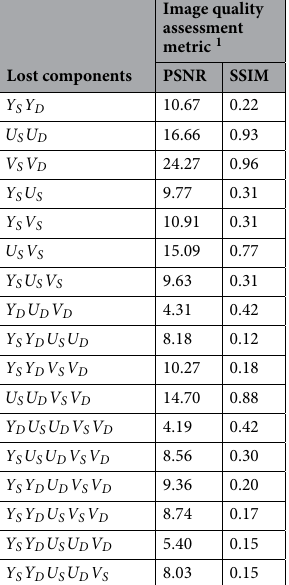
Table 6. The quality of the reconstructed image when some components are lost. The experimental results are obtained on the DRIVE dataset.